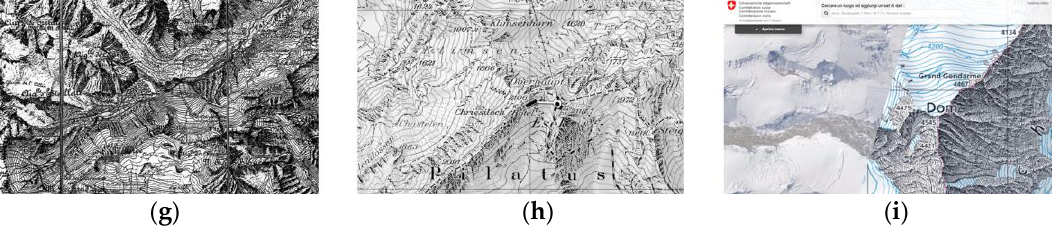
Figure 2. Some details from historical maps showing the progressive transformation of the cartographic representation of the Alps. ( a ) Berlinghieri F., 1482, as from [4] (p. 342); ( b ) Gastaldi G., 1548, as from [4] (p. 342); ( c ) Magini G.A., 1620, as from [4] (p. 342); ( d ) Borgonio G.T.,